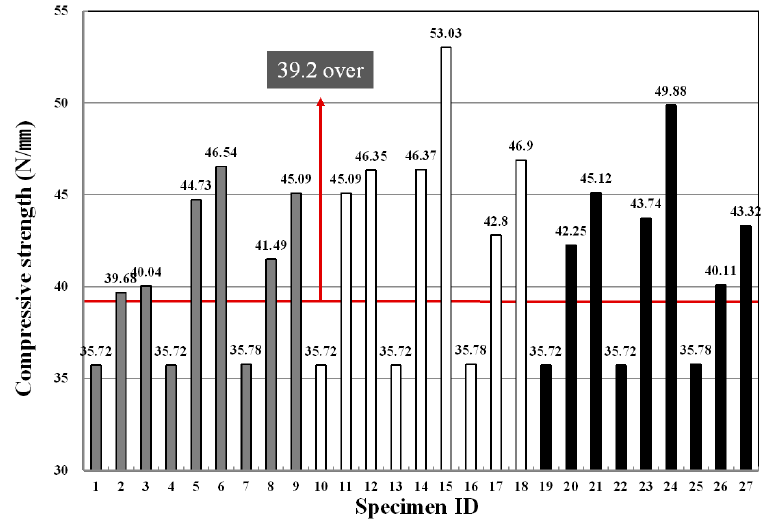
Figure 9. Variation of compressive strength for each specimen.